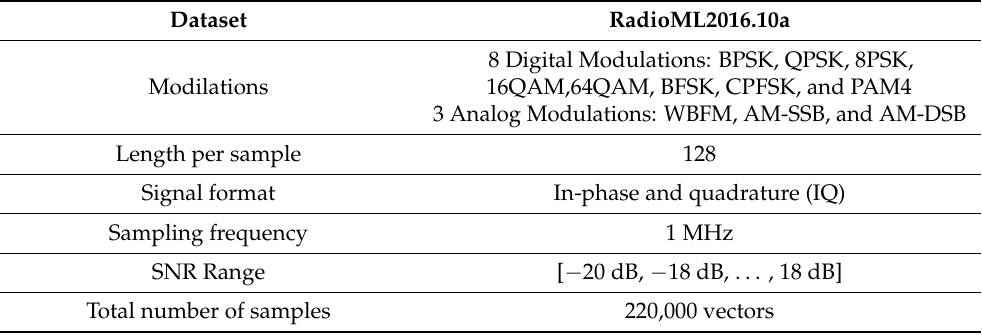
Table 2. RML2016.10a